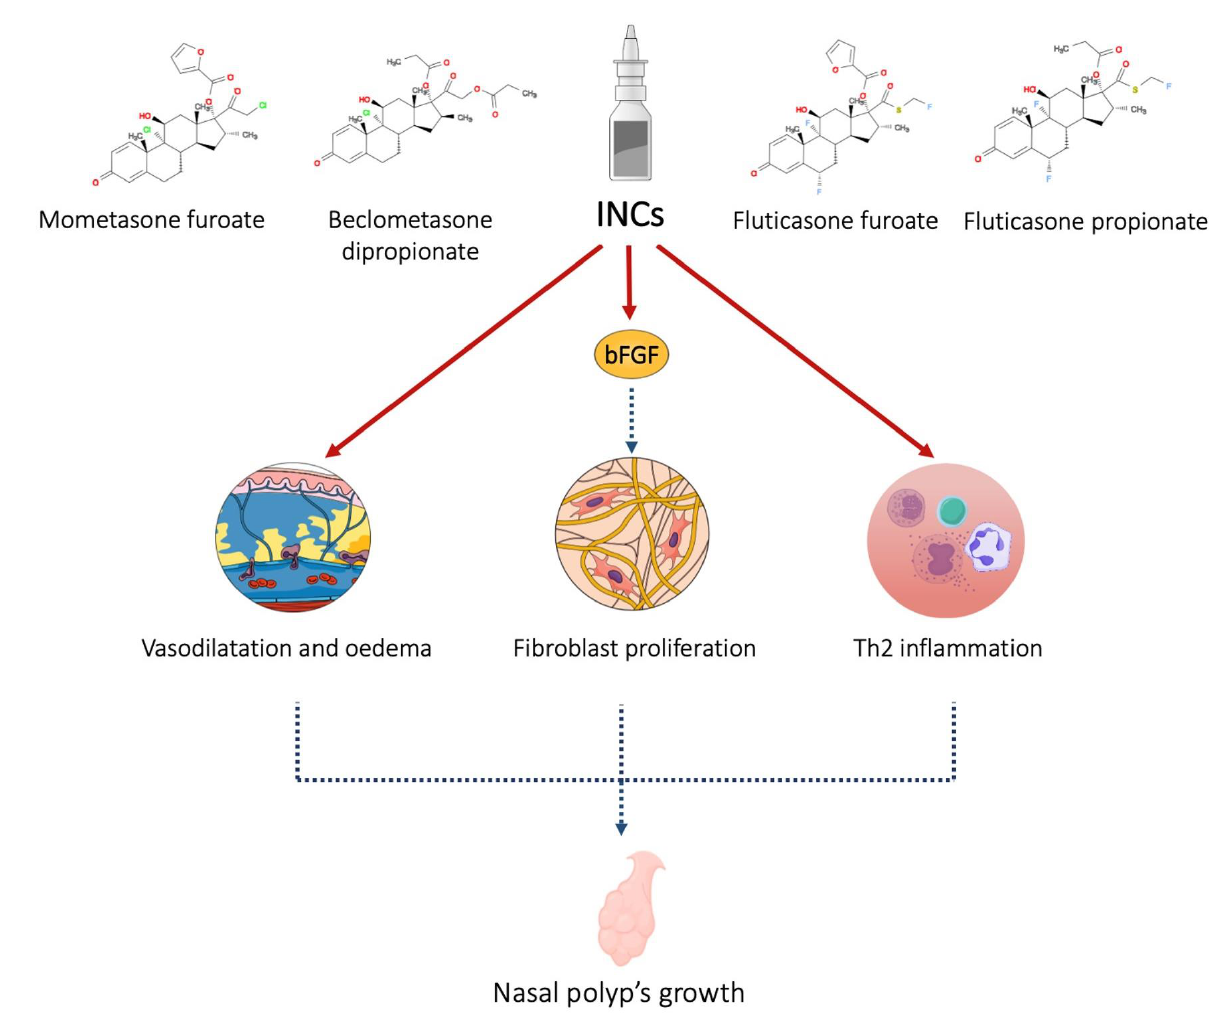
Figure 1. INCs act on the mucosa by reducing vasodilation and edema, inhibiting the production and release of pro-inflammatory cytokines. Furthermore, through the inhibition of basic fibroblast growth factor, they reduce the proliferation of fibroblasts and tissue remodeling.